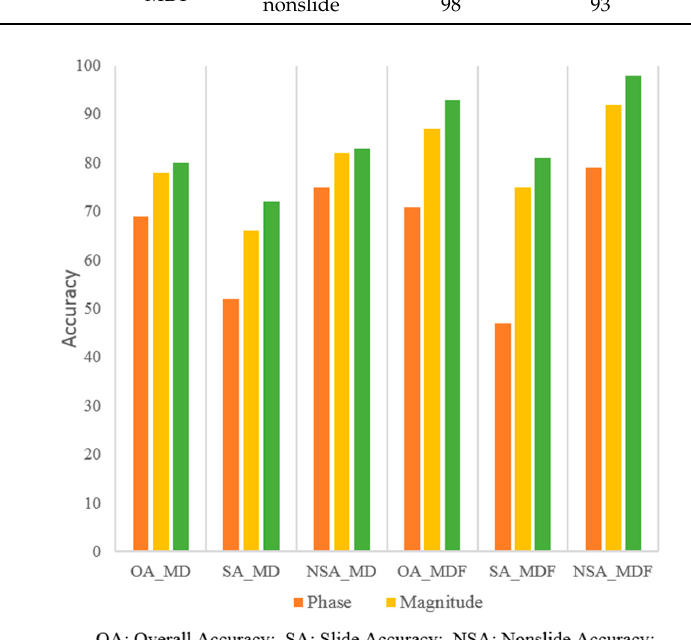
Figure 6. Accuracy comparison of the Mahalanobis distance classification and with majority filter, of the segment Sample 1, for the phase, magnitude, and complex data.